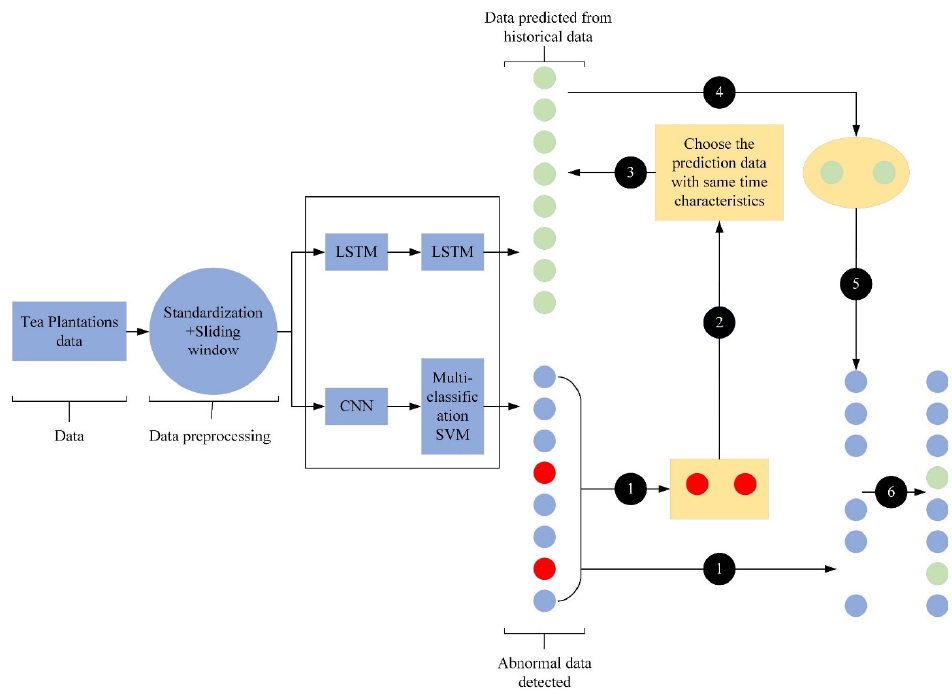
Figure 7. Abnormal Data Detection and Correction Model Structure Chart.